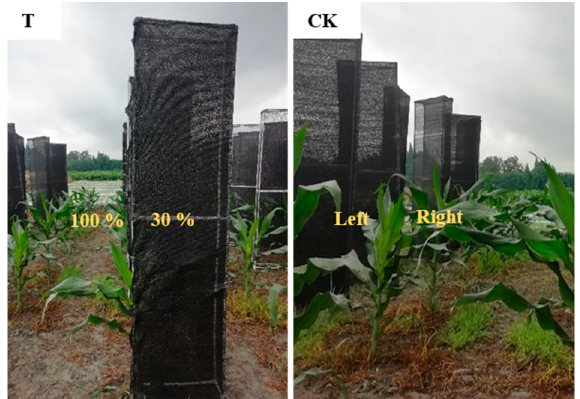
Figure 8. Design of shading treatments. T, all left-side leaves in maize plants from top to bottom were under normal light, whereas all the right-side leaves from top to bottom were in 30% of normal light. CK, the left and right maize leaves were under normal light.